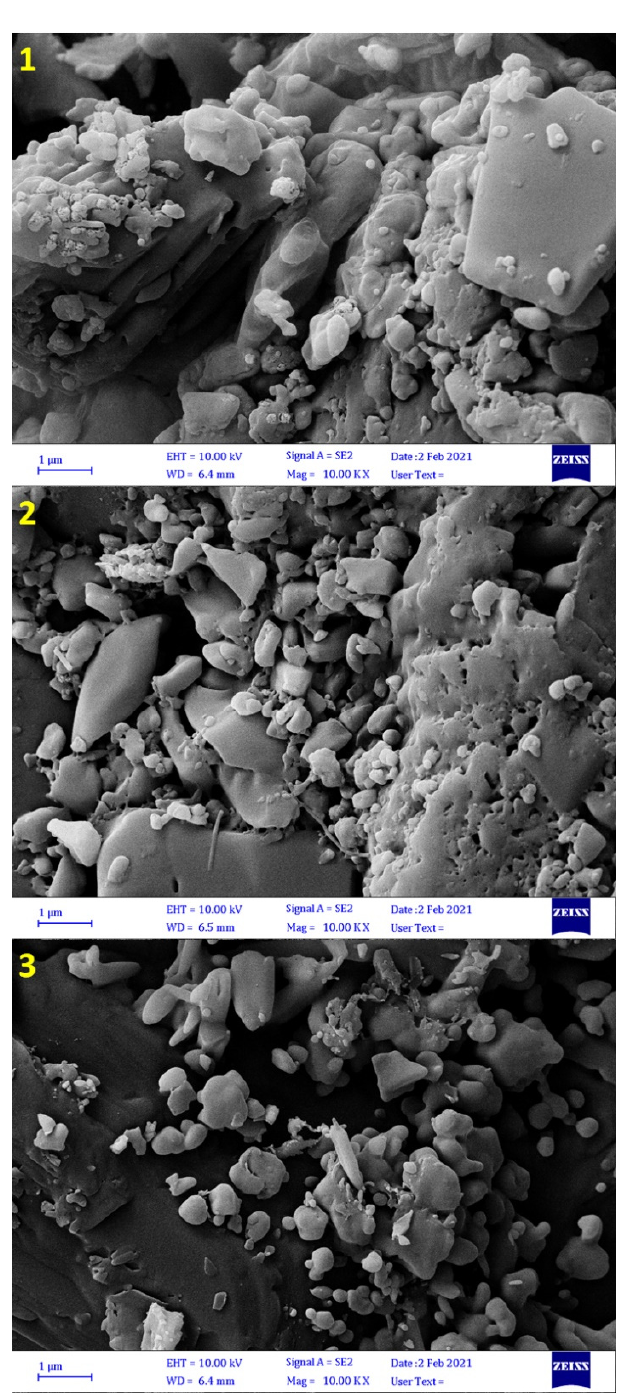
Figure 1. Field emission scanning electron microscope (FESEM) images of complexes 1–3 .